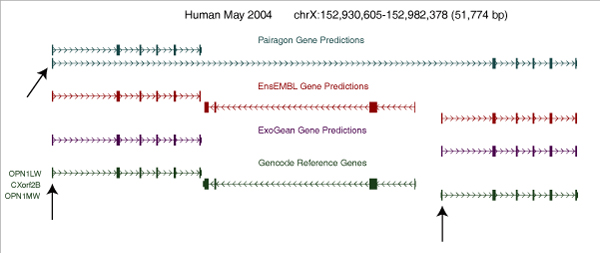
An incorrect alignment from Pairagon. The seed alignment from BLASTN aligned the 112-base exon at a location about 30 kb upstream (arrow in Pairagon gene prediction) instead of the annotated location (arrows in Gencode reference genes). Both alignments for that exon are 100% identical. (Screen shot obtained from UCSC Genome Browser web site [23].)